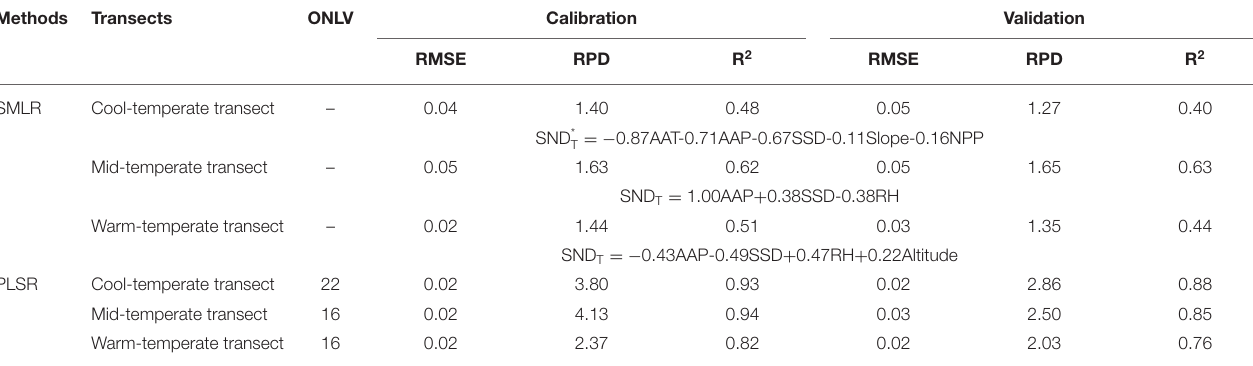
TABLE 4 | Parameters used to assess the temporal changes of soil nitrogen density (SND T ) prediction accuracy, the stepwise multiple linear regression (SMLR) models at the original scale, and the optimal number of latent variables (ONLV) for the partial least square regression (PLSR). Methods